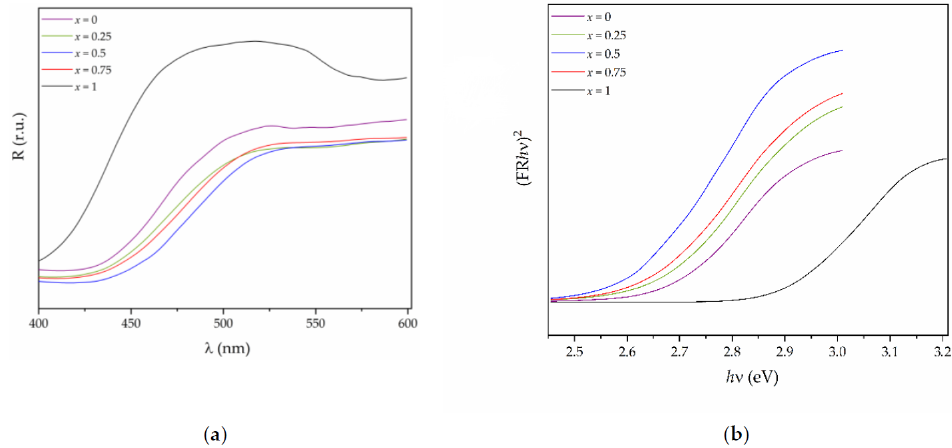
Figure 3. ( a ) UV-Vis spectra and ( b ) Tauc plots for Bi 2 W x Mo 1 − x O 6 layered perovskites.